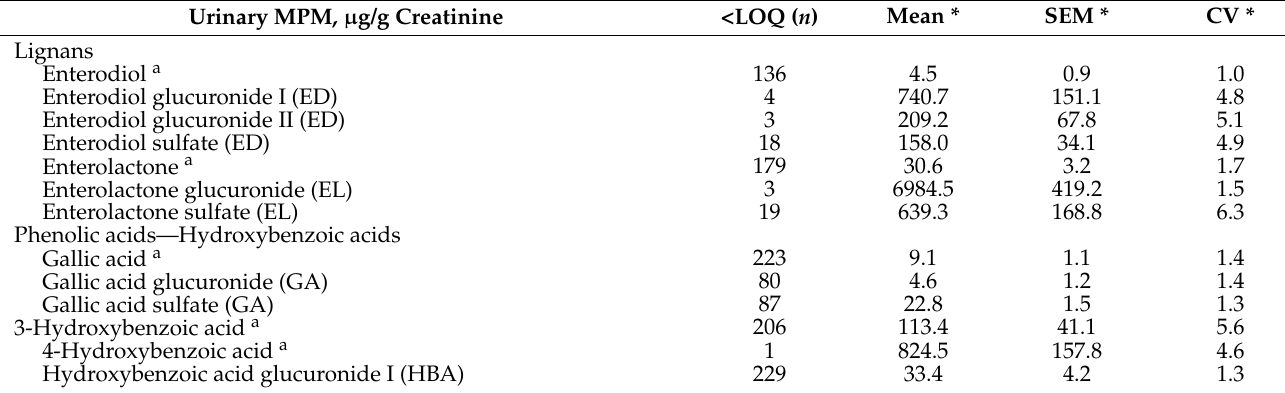
Table 3. Quantification of urinary MPM by HPLC-ESI-LTQ-Orbitrap-HRMS. Urinary MPM, µ g/g